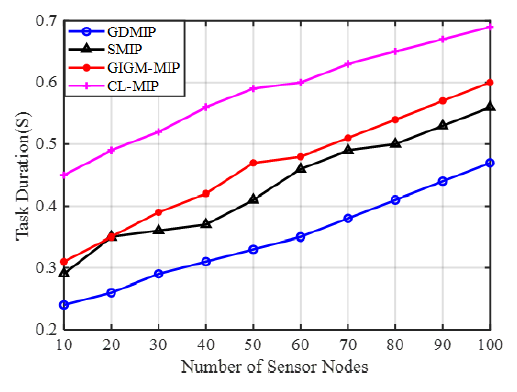
Figure 5. The Impact of the Number of Sensor Nodes on Task